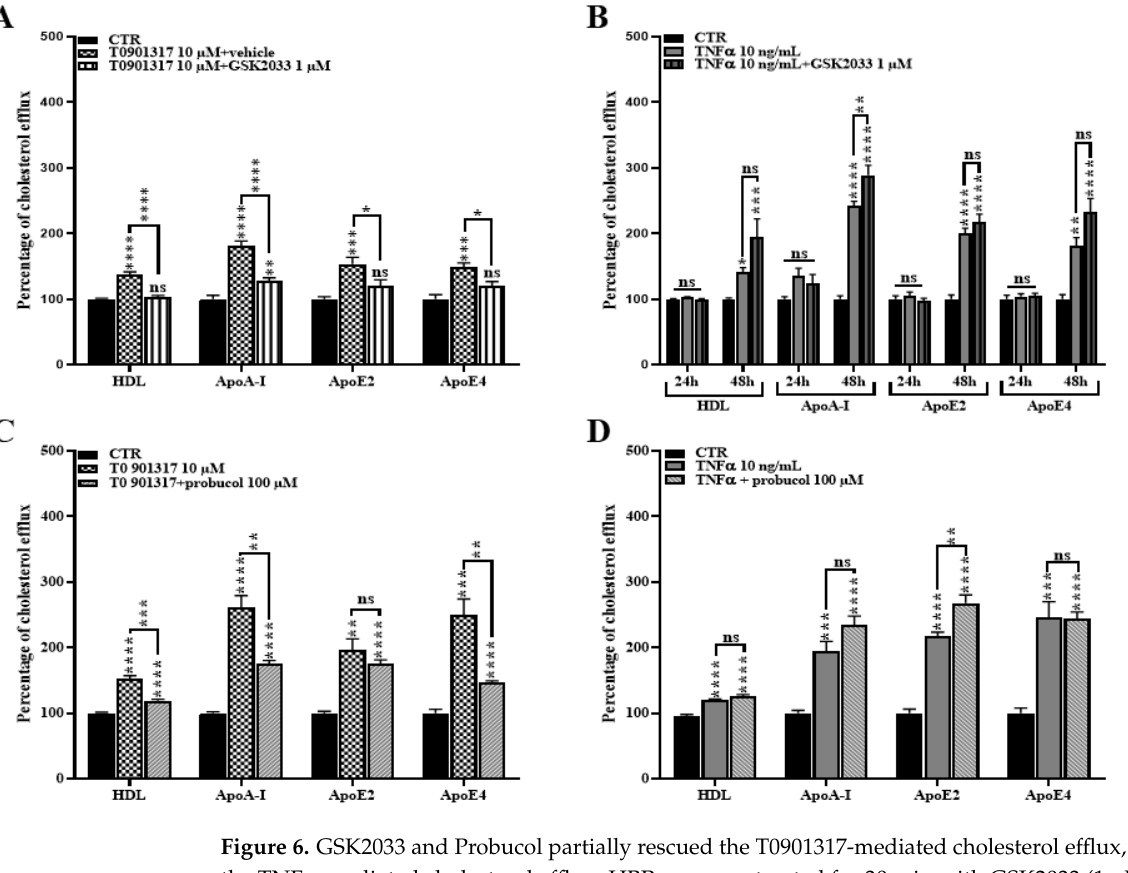
Figure 6. GSK2033 and Probucol partially rescued the T0901317-mediated cholesterol efflux, but not the TNFα -mediated cholesterol efflux. HBP were pre-treated for 30 min with GSK2033 (1 µM) then the LXR agonist T0901317 (10 µM) ( A ) was added in the supernatant for 24 h or the TNFα (10 ng/mL) ( B ) for 24 h and 48 h. Cholesterol efflux to lipid acceptors HDL (50 µg/mL), APOA-I (20 µg/mL), APOE2 and E4 (20 µg/mL) was then assessed during 8 h. Each bar represents the mean ± SEM of two independent experiments within four replicates each (N = 2; n = 8). Treated conditions were then compared with the control (CTR) conditions (100%). Statistical analysis: one-way ANOVA followed by Tukey’s multiple comparison test, ns: non-significant, * p < 0.05, ** p < 0.01, *** p < 0.001, **** p < 0.0001. Human brain pericytes were treated for 24 h with the LXR agonist T0901317 (10 µ M) ( C ) and for 48 h with TNF α (10 ng/mL) ( D ). Cholesterol efflux to lipid acceptors HDL (50 µ g/mL) and APOA-I , APOE2 , APOE4 (20 µ g/mL) was then assessed during 8 h in the presence or absence of the ABCA1 inhibitor, Probucol (100 µ M). Each bar represents the mean ± SEM of two independent experiments within four replicates each (N = 2; n = 8). Treated conditions were then compared with the control (CTR) condition (fixed at 100%). Statistical analysis: one-way ANOVA followed by Tukey’s multiple comparison (for equal variances) and one-way ANOVA Welsh test followed by Games-Howell’s multiple comparison (for significantly different variances): ns: non-significant, * p < 0.05, ** p < 0.01, *** p < 0.001, **** p <